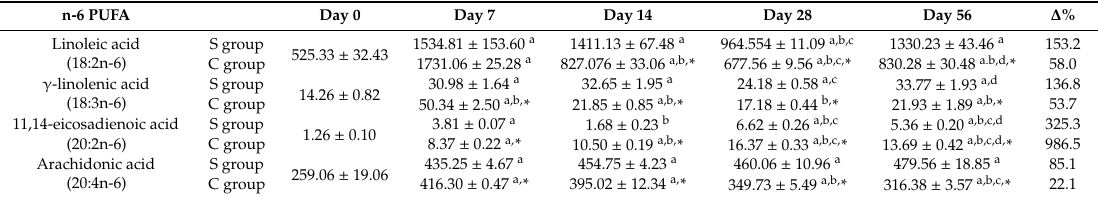
Table 5. Polyunsaturated n-6 fatty acid (n-6 PUFA) composition (mg / 100g of sample) in the livers of mice fed with a diet containing soybean oil (S group) or canola oil (C group) as a lipid source, at 0, 7, 14, 28, or 56 days after starting the diets.